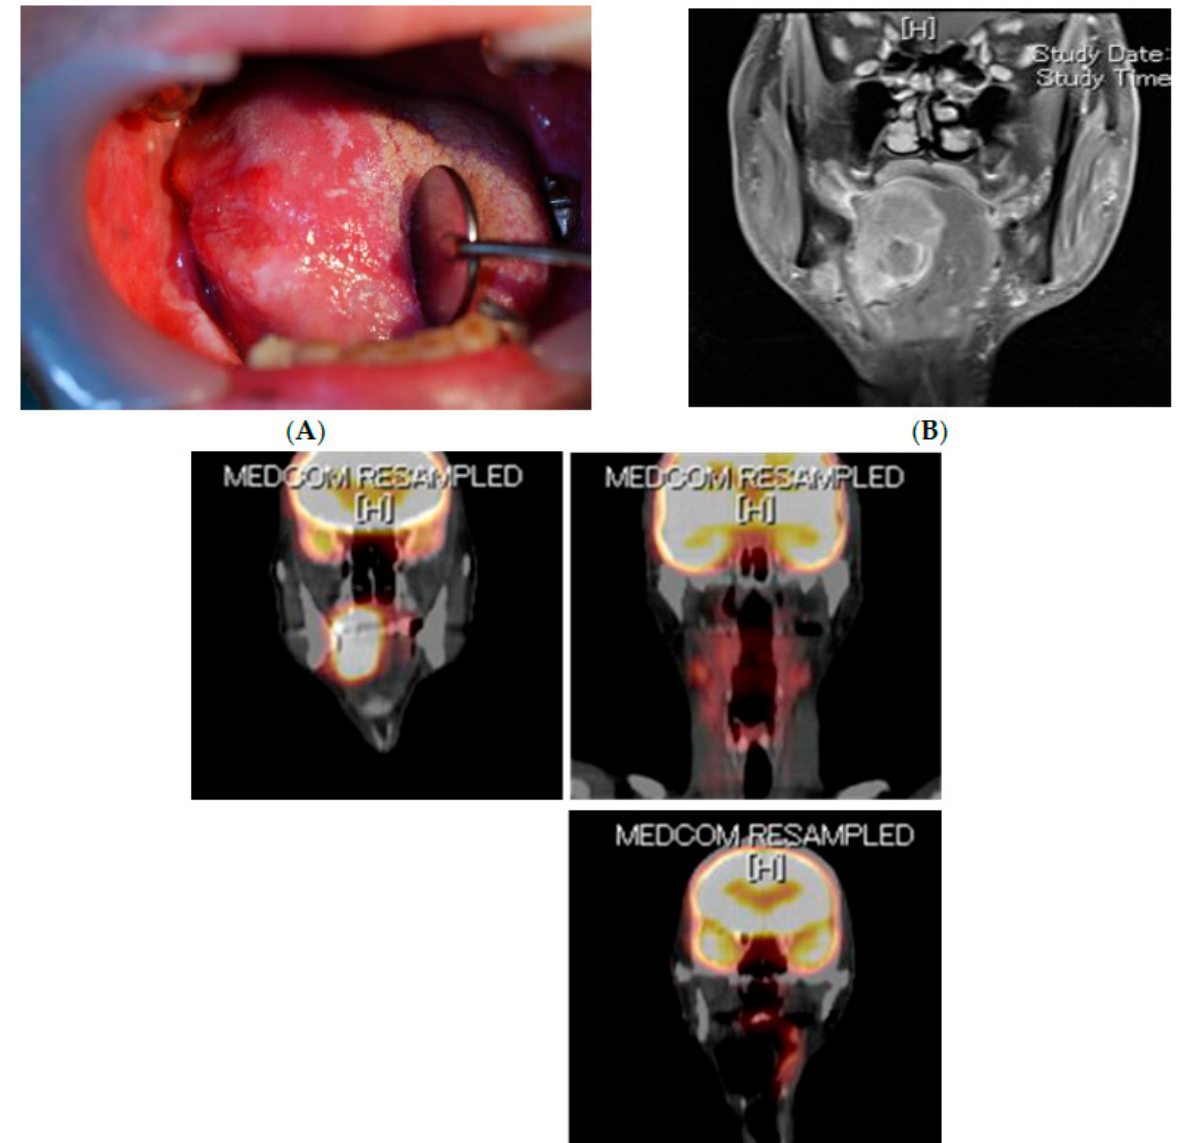
Figure 2. A 65-year-old male patient with right SCC of the tongue (T4aN2cM0, tumor diameter was 62 × 39 mm, depth of invasion was 30 mm, and degree of differentiation was moderate; surgical margins were negative) underwent bilateral radical neck dissection, total removal of the tongue, and reconstruction with a rectus abdominis musculocutaneous flap. The patient has survived and been disease-free for ≥ 5 years since the surgery. ( A ) Photograph of the oral cavity at the first hospital visit. ( B ) MRI at the first hospital visit. ( C ) FDG-PET/CT at the first hospital visit.